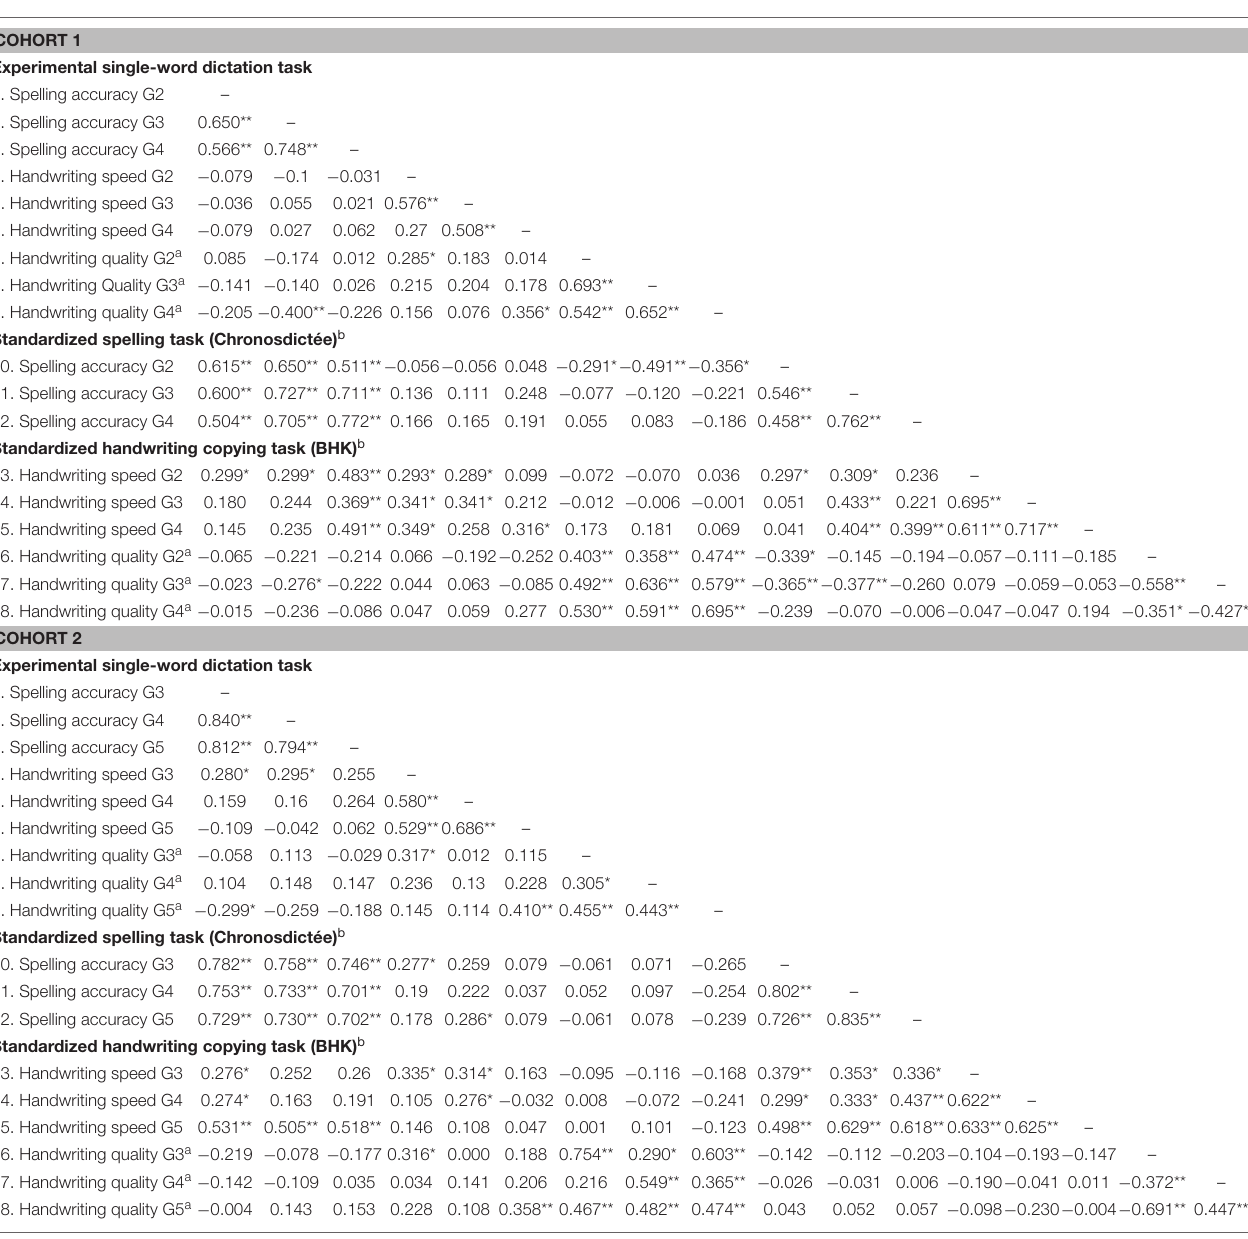
TABLE 3 | Correlations between experimental and control measures of spelling and handwriting abilities at the three measurement times in cohort 1 and cohort 2.